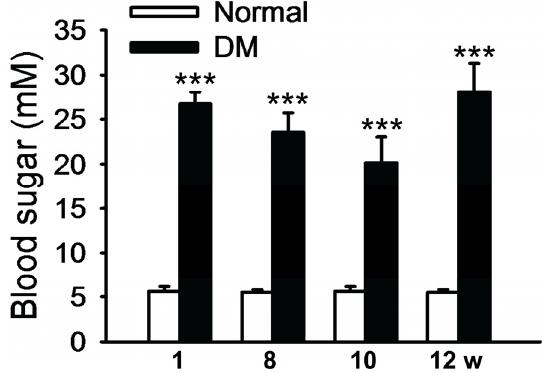
Figure 1. Blood glucose in STZ-induced diabetic rats. Blood glucose in the normal and diabetes mellitus (DM) groups was examined at weeks 1, 8, 10, and 12 following diabetic induction. The data represent mean ± SE, n = 5–14, *** p < 0.001, Normal vs.